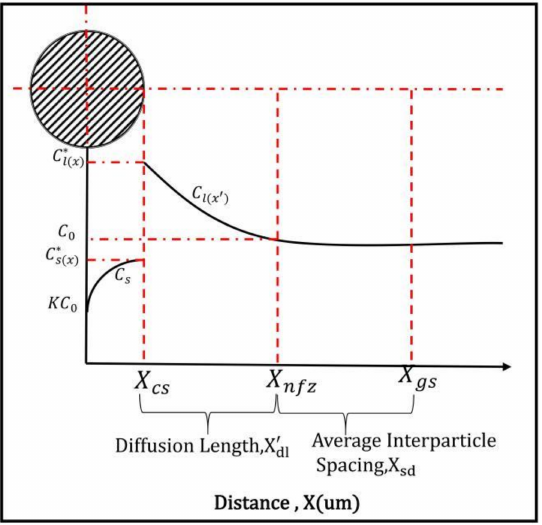
Figure 3. The distribution relationship of the solute in the liquid and solid phases during the formation of the grain. Figures taken from Acta Materialia [34] with